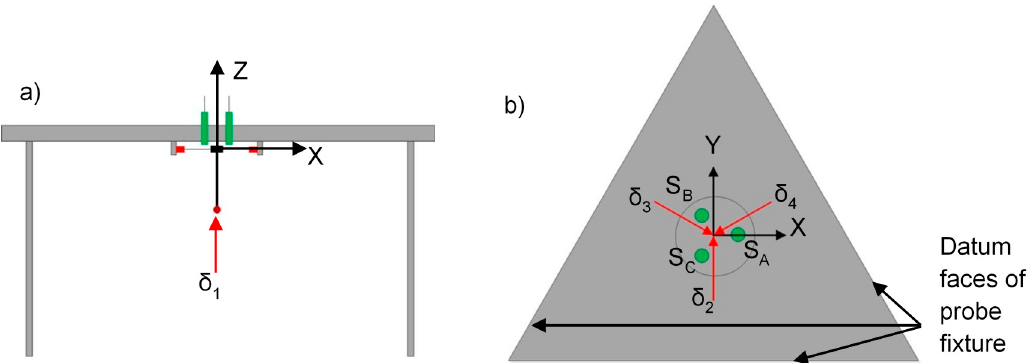
Figure 9. Schema showing ( a ) a front view of the platform that was used to calibrate the probing system in z axis; ( b ) a top view of the platform that indicate the position of three capacitive sensors and the calibration directions of the probing system in x and y axes.